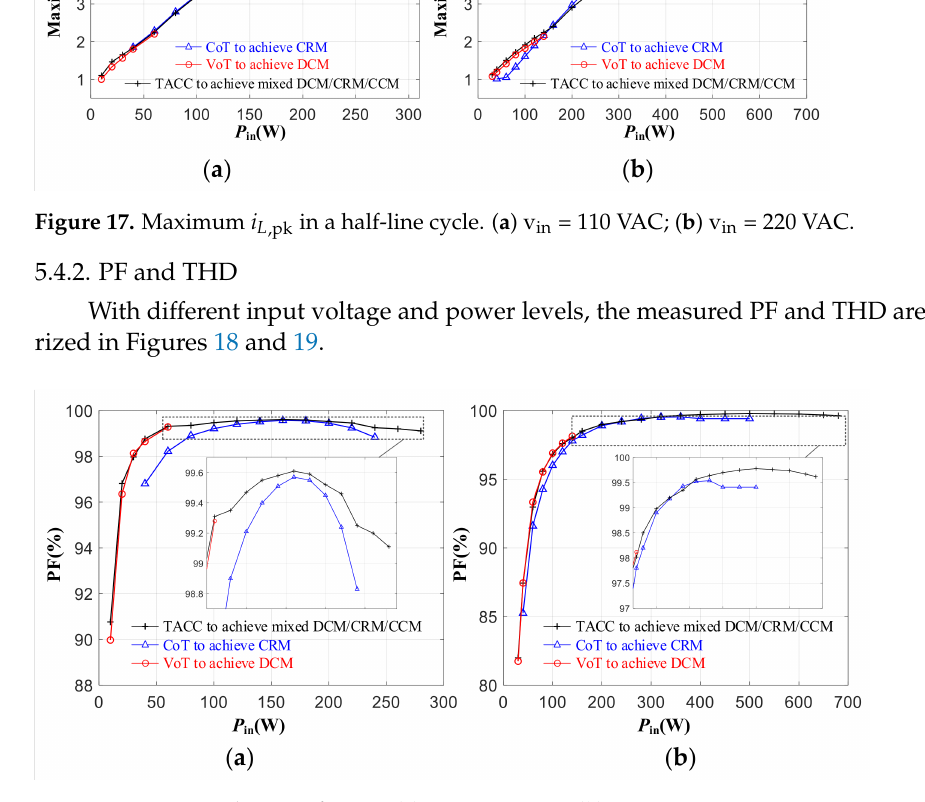
Figure 18. Measured power factors. ( a ) v in = 110 VAC; ( b ) v in = 220 VAC.